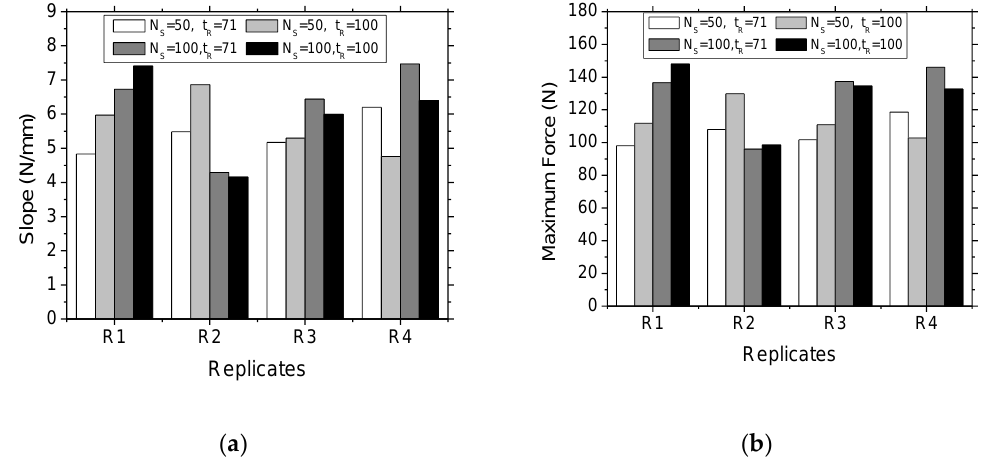
Figure 8. Influence of the randomness in Voronoi–Monte Carlo generation scheme on the measured ( a ) slope and, ( b ) maximum bending force of printed cellular wrenches for two different populations of seed points ( 𝑁 𝑠 = 50) and ( 𝑁 𝑠 = 100).